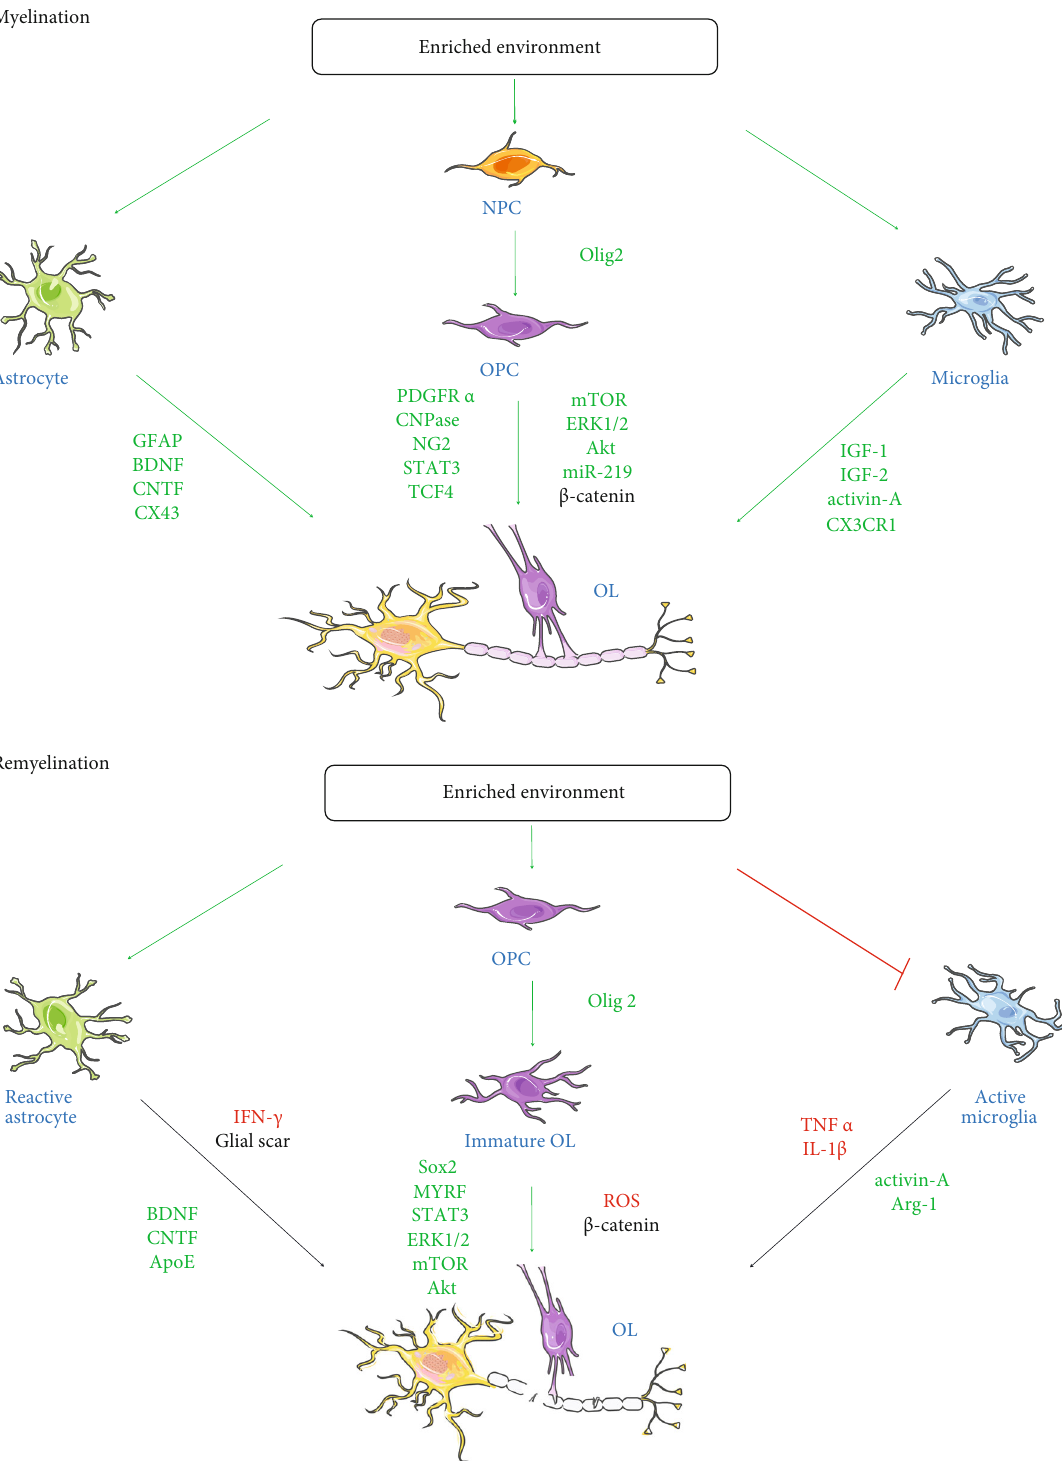
Figure 3: An overview of the e ff ect of enriched environment on glial cells in myelination and remyelination. Please refer to the text for details. The green arrows indicate molecules exhibiting positive activity on oligodendrocyte lineage and myelin production, the red arrows and blocking symbols indicate molecules displaying inhibiting activity on oligodendrocyte lineage production whereas the black arrows indicate molecules exhibiting dual activity on oligodendrocyte lineage and myelin